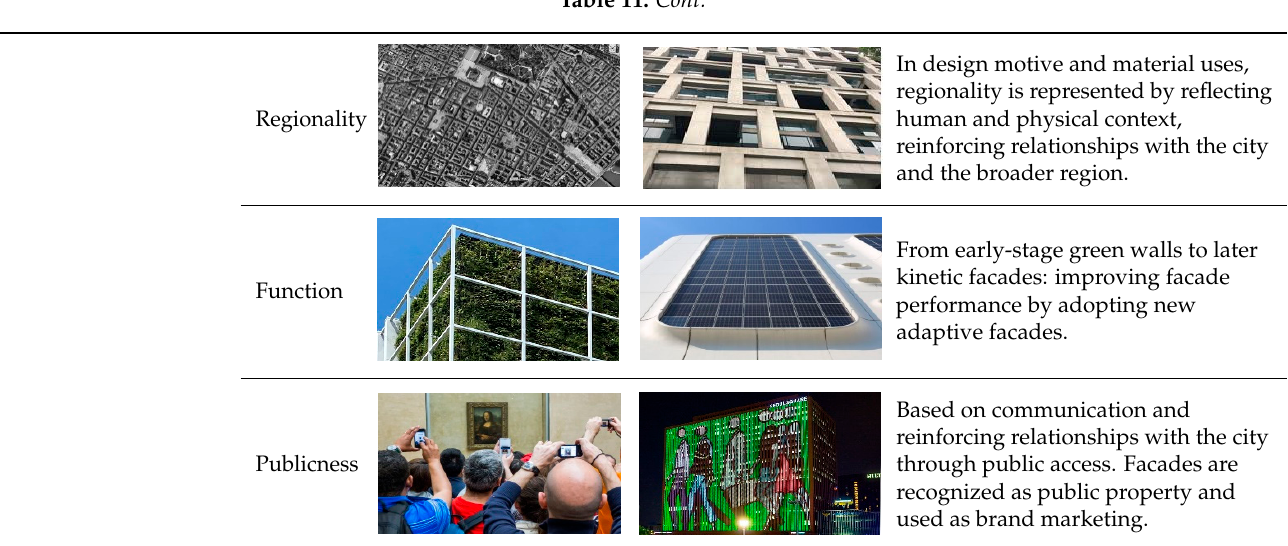
◑ Table 11. Trends of expression for each assessed element.